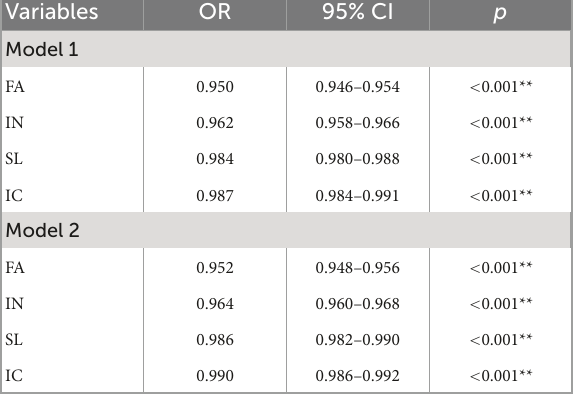
Model 1: adjusted for age and gender; Model 2: adjusted for age, gender, number of children in the family, parental preference, parental relationship, and monthlyfamilyincome. ** p < 0.001.